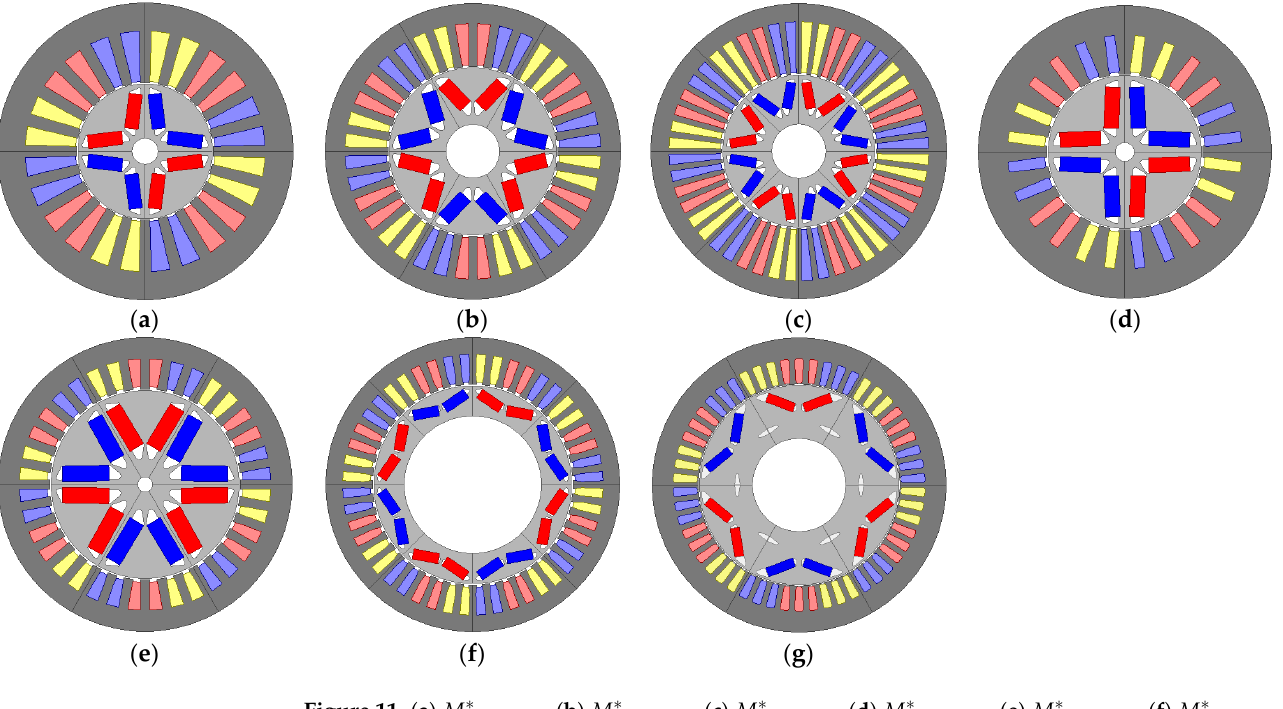
Figure 11. ( a ) 𝑀 (cid:2870)(cid:2868)(cid:2879)(cid:2870)(cid:2879)(cid:3004)(cid:3021)∗ , ( b ) 𝑀 (cid:2870)(cid:2868)(cid:2879)(cid:2871)(cid:2879)(cid:3004)(cid:3021)∗ , ( c ) 𝑀 (cid:2870)(cid:2868)(cid:2879)(cid:2872)(cid:2879)(cid:3004)(cid:3021)∗ , ( d ) 𝑀 (cid:2870)(cid:2868)(cid:2879)(cid:2870)(cid:2879)(cid:3015)(cid:3021)∗ , ( e ) 𝑀 (cid:2870)(cid:2868)(cid:2879)(cid:2871)(cid:2879)(cid:3015)(cid:3021)∗ , ( f ) 𝑀 (cid:2870)(cid:2868)(cid:2879)(cid:2872)(cid:2879)(cid:3015)(cid:3021)∗ , ( g ) Figure 11. ( a ) M ∗ , ( b ) M ∗ , ( c ) M ∗ , ( d ) M ∗ , ( e ) M ∗ , ( f ) M ∗ , 20 − 2 − NT 20 − 3 − NT 20 − 4 − NT 20 − 2 − CT 20 − 3 − CT 20 − 4 − CT Machine used in Tesla Model 3. ( g ) Machine used in Tesla Model